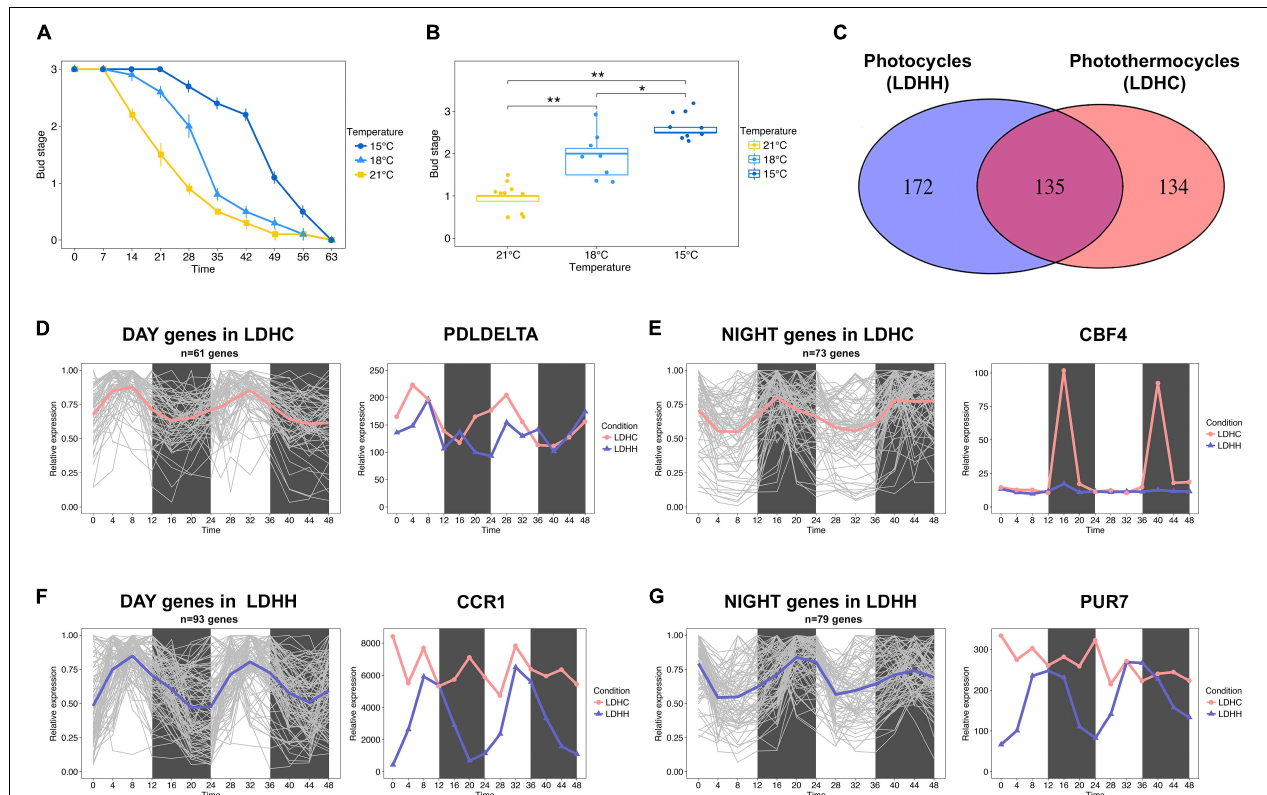
FIGURE 1 | Bud set-associated genes in poplar are sensitive to low ambient temperature. (A) Bud set scores for hybrid poplar ( Populus tremula x P. alba ) plants grown under SD and three different temperatures (21, 18, and 15 ◦ C) for 9 weeks. (B) Comparative analysis of hybrid poplar bud stage progression in plants grown under SD and three different temperatures (21, 18, and 15 ◦ C) over 4 weeks. Asterisks denote significant differences between hybrid poplar plant groups ( n = 8) grown at different temperatures (Kruskal–Wallis test followed by pairwise Wilcox test; ∗ P < 0.05, ∗∗ P < 0.01). (C) Venn diagram representing the intersection between genes with SNPs associated with bud set and that show robust diurnal oscillations (cut-off = 0.8) under light/dark cycles (LD) and constant temperature (25 ◦ C, HH) or photothermocycles (25 ◦ C during the day, 12 ◦ C during the night, HC). 172 genes (lilac) show robust diurnal rhythms only under LDHH, 134 genes (pink) show diurnal rhythms only under LDHC and 135 genes (fuchsia) oscillate under both conditions, respectively. (D,E) Clusters of genes that show diurnal expression within 0–11 h under LDHC ( D , mean = pink) and within 12–23 h under LDHC ( E , mean = pink). The line chart demonstrates how photothermocycles (LDHC) promote diurnal oscillation of poplar PDLDELTA (D) and CBF4 genes (E) . (F,G) Clusters of genes that show diurnal expression within 0–11 h under LDHH ( F , mean = lilac) and within 12–23 h under LDHH ( G , mean = lilac). The line chart demonstrates how photothermocycles (LDHC) disrupt the diurnal oscillation of poplar CCR1 (F) and PUR7 genes (G)